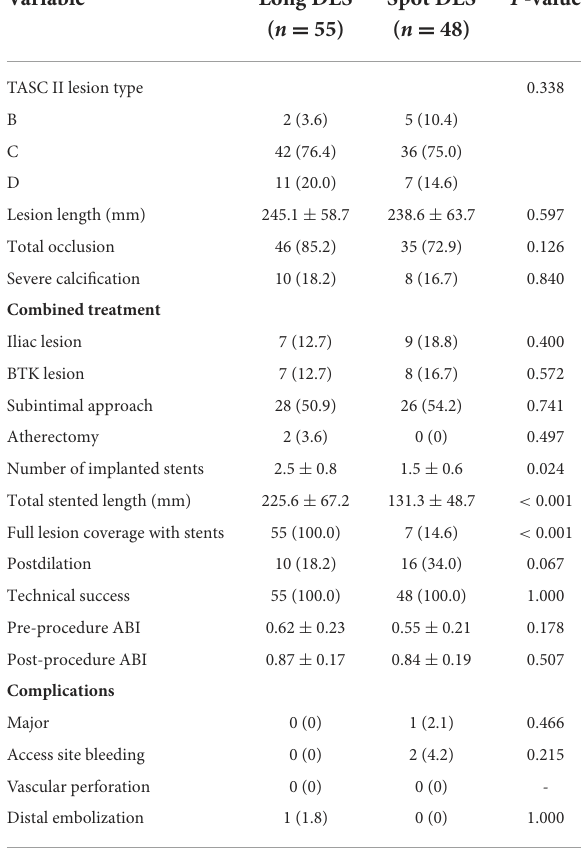
TABLE 2 Lesion and procedural